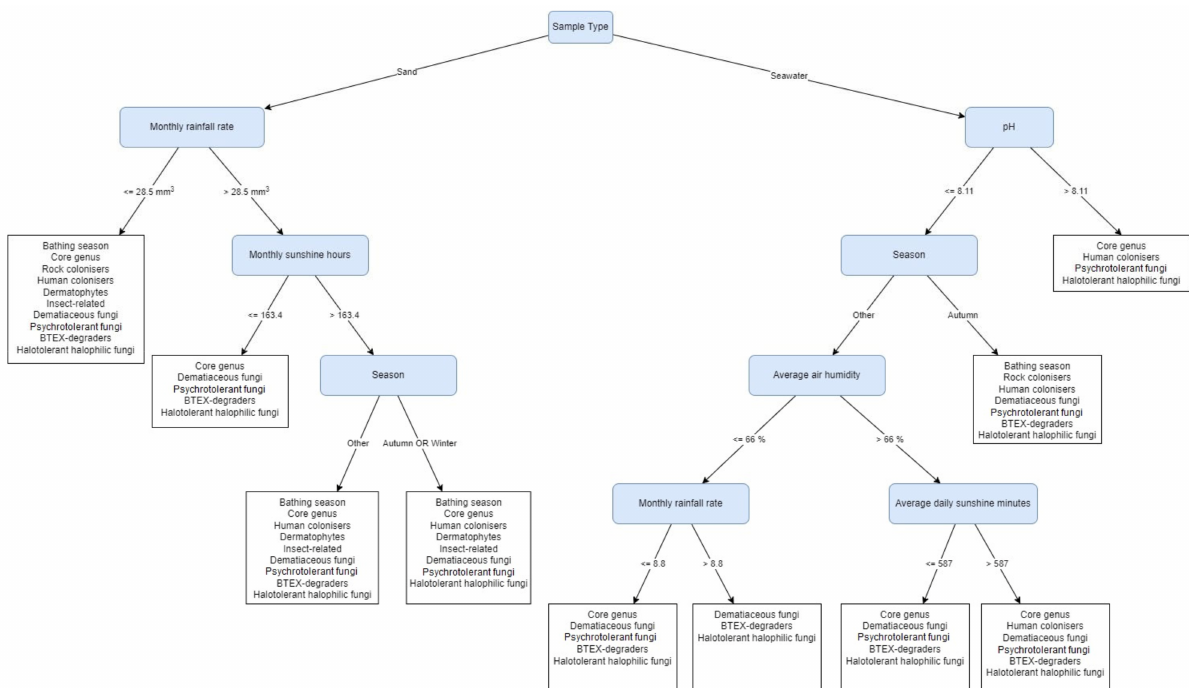
Figure 2. The Predictive Clustering Tree (PCT) for multi-label classification (MLC), predicting the presence of fungal functional groups, isolated from beach sand and seawater. The decision process starts by separating samples based on their type (sand or seawater). From there on, Monthly rainfall rate, Monthly sunshine hours, Season, pH, Average air humidity and Average daily sunshine minutes are used to determine the prediction of the tree. For example, if samples come from seawater and their pH is higher than 8.11, the predicted labels (functional groups) are: Core genus, Human colonisers, Psychrotolerant fungi, and Halotolerant/halophilic